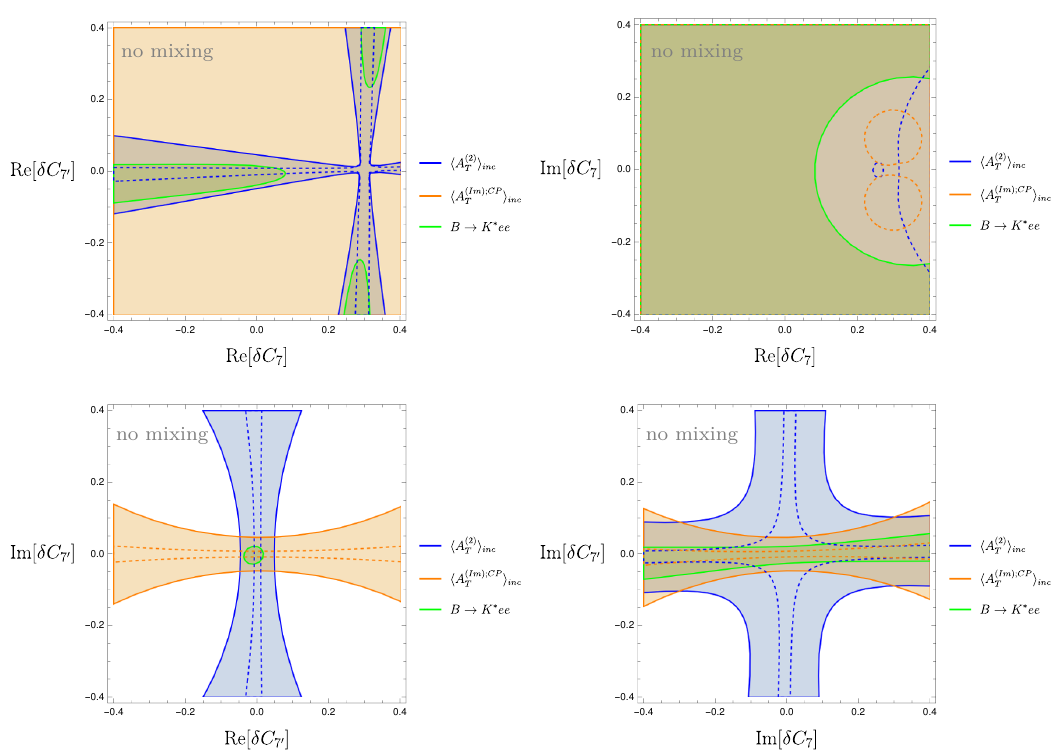
Figure 4 . Projected 1 σ contours on NP contributions to C 7 and C 7 0 from B s → φee observables at low q 2 : h A (2) i inc and h A ( Im ); CP i inc . Four NP scenarios are shown: (i) Re( C 7 ) vs. Re( C 7 0 ) , (ii) Re( C 7 ) T T vs. Im( C ) , (iii) Re( C ) vs. Im( C ) and (iv) Im( C ) vs. Im( C ) . The SM point corresponds to the 7 7 0 7 0 7 7 0 origin (0,0). For illustration, meson mixing is not taken into account for B observables. The s → φee dashed lines correspond to the future projections (300 fb − 1 ) for A (2) (blue) and A ( Im ); CP T T